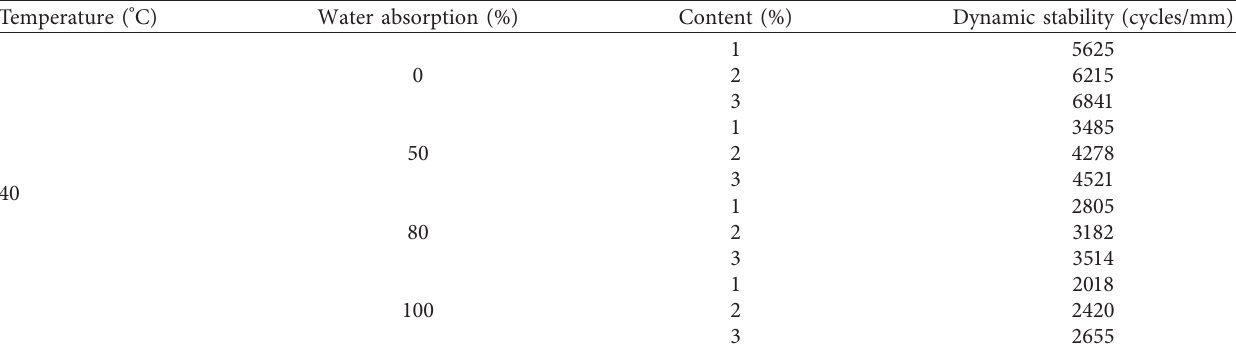
Table 9: AC-13 nano-SiO 2 -modified asphalt dynamic